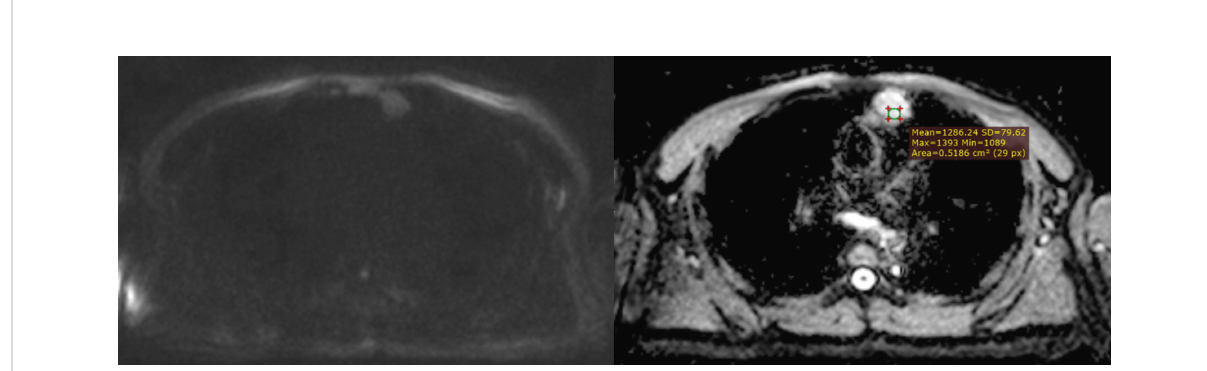
FIGURE 9 A case of false prediction using the hot-spot-ROI-based ADC cutoff of 0.99 x 10 -3 mm 2 /sec. A pathologically-proven type B3 thymoma was falsely presumed as a low-risk thymoma according to its rather high ADC value. The mean of 3 ADC values obtained by using the hot-spot- ROI-based approach was 1.15 x 10-3 mm2/sec, which was obviously higher than the cutoff of 0.99 x 10-3